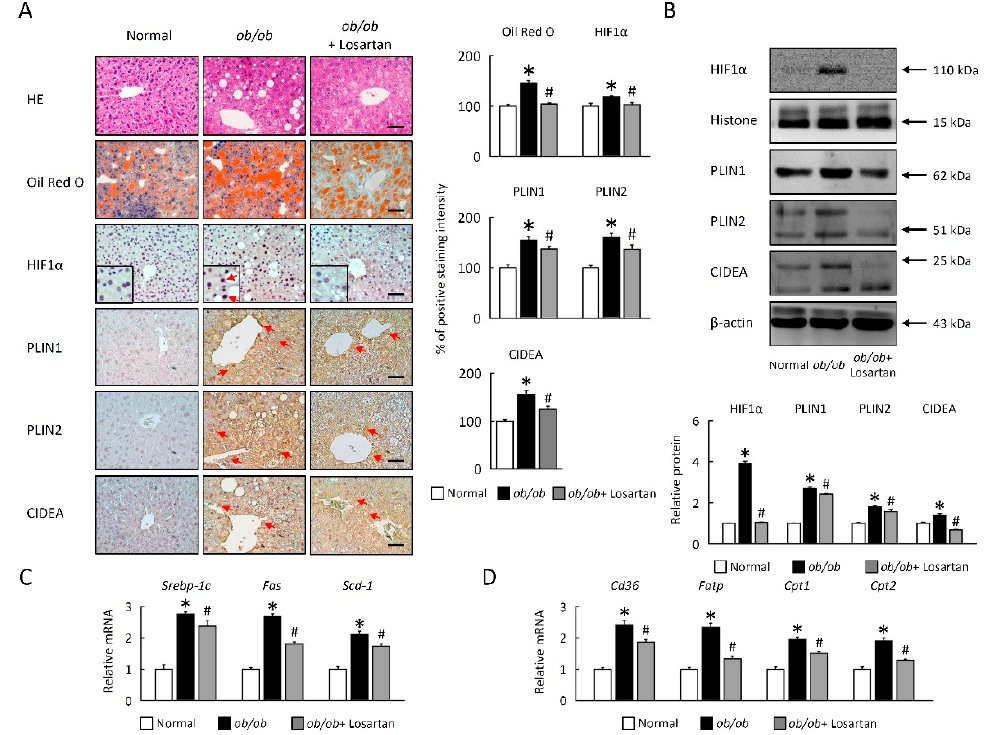
Figure 7. Losartan reduced LDs accumulation and lipogenesis in liver. ( A ) Representative HE, Oil Red O, HIF1 α , PLIN1, PLIN2, and CIDEA staining of liver. Red arrow highlights the positive staining. Scale bar: 100 µ m. Tissue staining, as quantified by either stain intensity, is represented on the left-hand vertical axis in each graph. ( B ) Quantification of HIF1 α , PLIN1, PLIN2, and CIDEA protein levels in homogenates of liver. Below graphs indicate quantification relative to Histone (for HIF1 α ) and β -actin (for PLIN1, PLIN2, and CIDEA). ( C ) Quantification of Srebp-1c , Fas and Scd1 , ( D ) Cd36 , Fatp , Cpt1 , and Cpt2 by qRT-PCR. For each animal group, n = 5. All values represent the mean ± SEM. Data were analyzed by Student’s t test. * p ≤ 0.05, normal vs. ob/ob ; # p ≤ 0.05, ob/ob vs. ob/ob + Losartan. HIF1: hypoxia-inducible factor 1; LDs: lipid droplets; HE: hematoxylin and eosin stain; PLIN1, perilipin 1; CIDEA, cell death inducing DFFA like effector A; SREBP: sterol response element-binding protein; Fas : fatty acid synthase; Scd : stearoyl-CoA desaturase; Cd36 : cluster of differentiation 36; Fatp : fatty acid transport protein; Cpt1 : carnitine palmitoyltransferase 1; qRT-PCR: quantitative real time polymerase chain reaction.